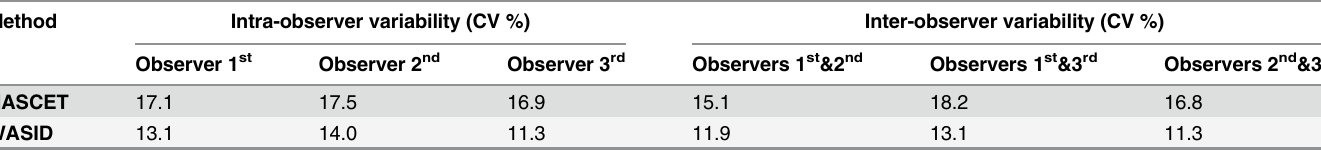
Table 4. The mean CVs of intra- and inter-observer of the MCA stenosis measurements between the two methods.